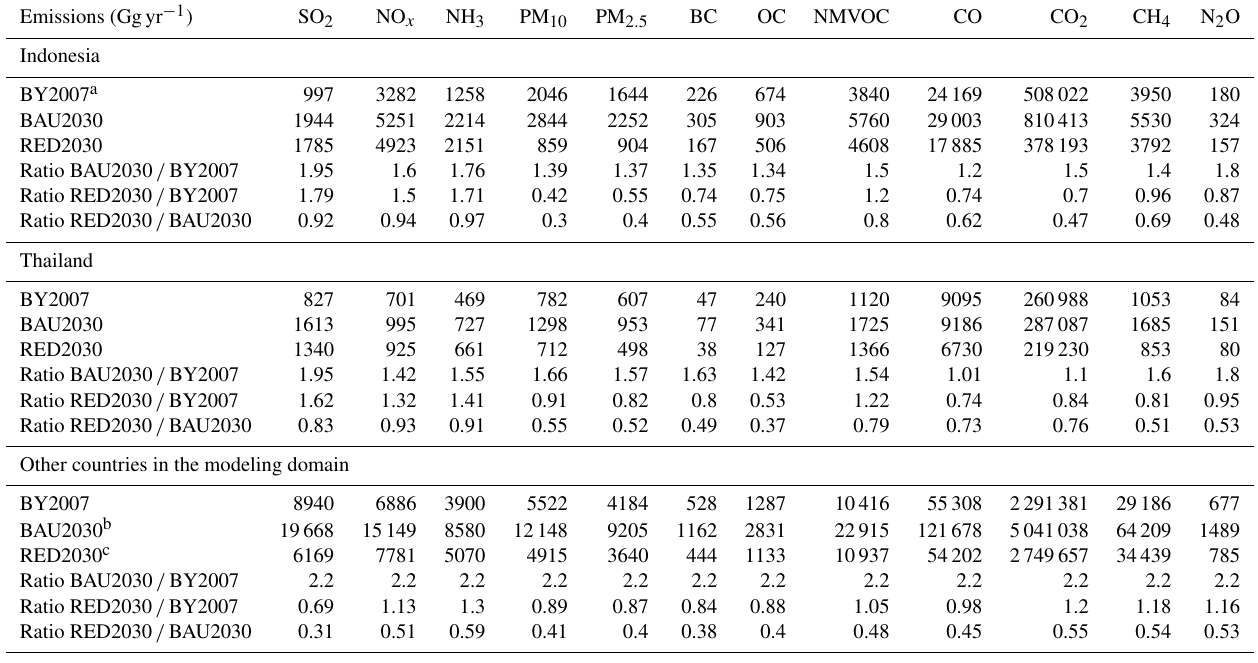
Table 1. Emissions of BY2007, BAU2030 and RED2030 for Indonesia, Thailand and other countries in the modeling domain. Emissions (Ggyr − 1